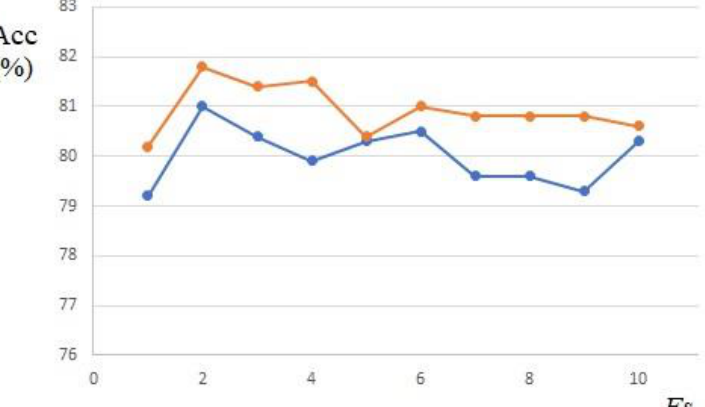
Figure 6. Testing accuracy obtained by di ff erent filter sizes apart from 200 filters of size 2, for English ( red ) and Italian ( blue ).